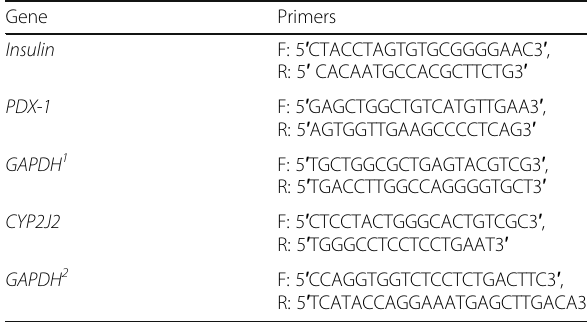
PCR cycling conditions